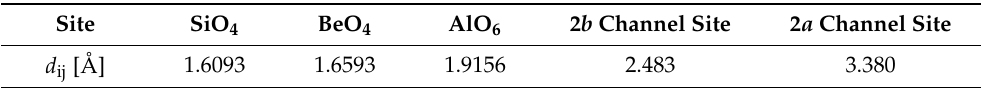
Table 2. Empirical average bond lengths ( d ij ) for selected cation-oxygen bonds in the beryl structural sites (empirical data from